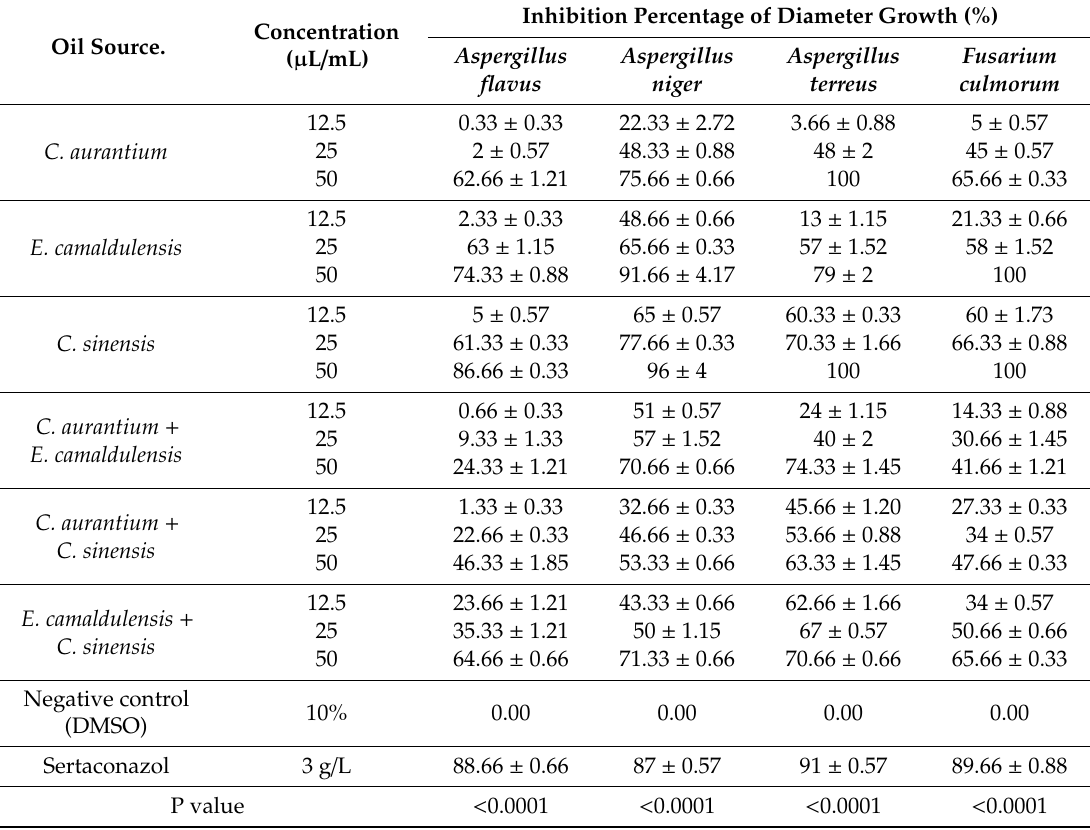
Table 5. Inhibition percentage of the diameter growth of A. flavus, A. niger , A. terreus , and F. culmorum as a ff ected by essential oils from C. aurantium , E. camaldulensis , and C. sinensis and their combinations.